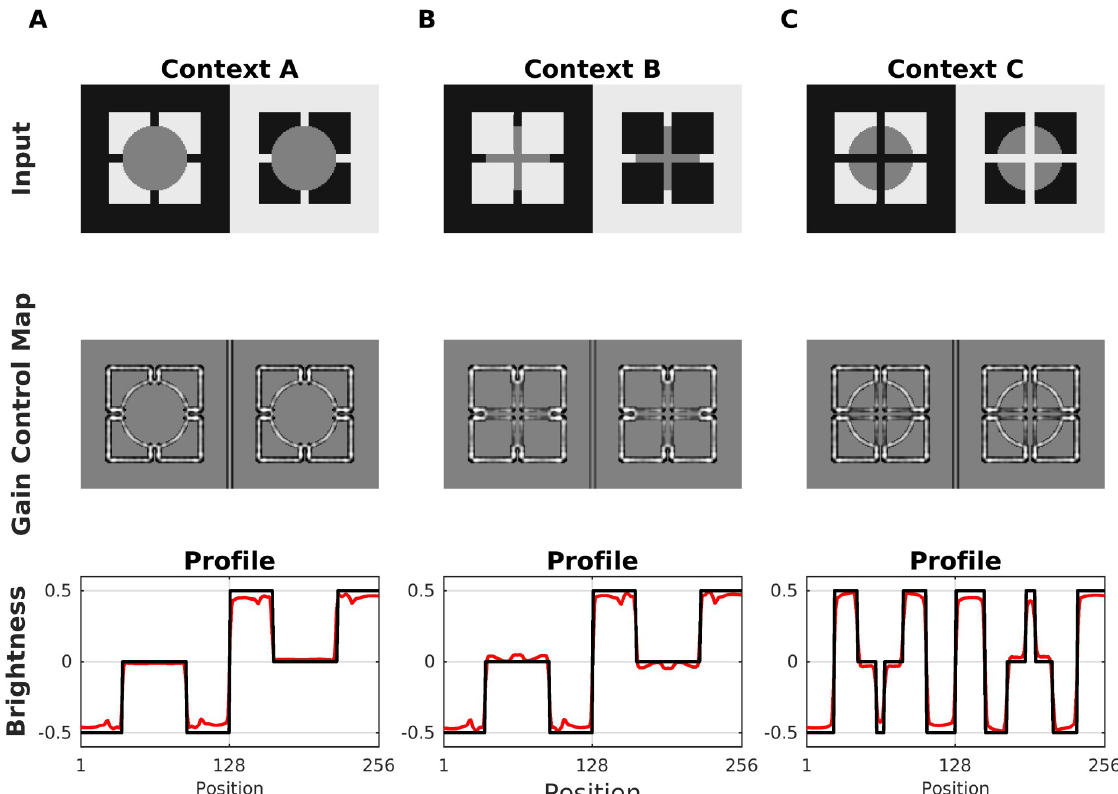
Fig 14. Model prediction for Todorovic’s illusion. (A) Top: A variation of Todorovic’s original illusion with the gray disks in the foreground (Context A). An effect is hardly perceivable. Middle: The corresponding Gain Control Map. Bottom: Profile plots of estimated brightness (red line) and luminance (black line). The model predicted at most a very weak effect. (B) Original Todorovic Illusion (Context B), where the occluded left disk is perceived as being brighter. (C) Reversed Todorovic Illusion (Context C). Now it looks like viewing the disks on a single square background through a window cross, and the left disk is perceived as being